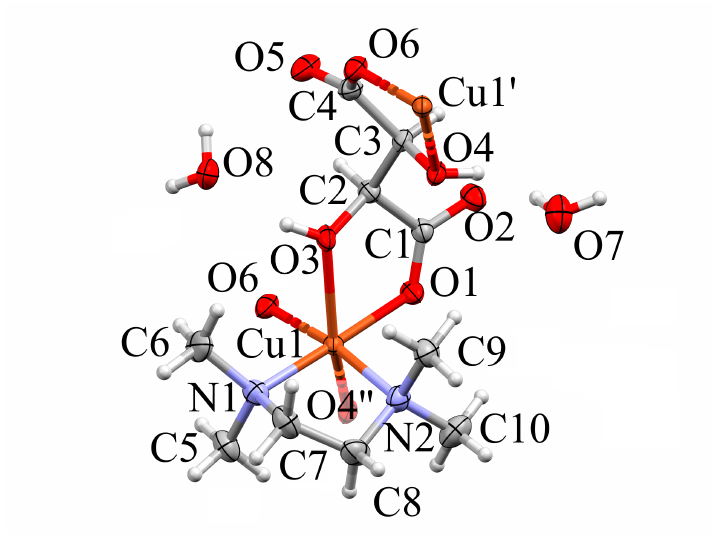
Figure 3. Expanded asymmetric unit of 2a (Mercury, [42]). Non-hydrogen atoms in the complex are shown as ellipsoids (70% probability), H as spheres with fixed radius of 0.15 Å. Coordination distances